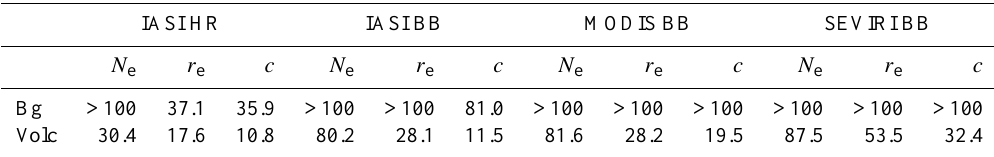
Table 4. Total error (%) for the retrieval of the three aerosol parameters: N e , r e and H 2 SO 4 mixing ratio, with different instrumental configurations (IASI HR refers to the IASI high spectral resolution; IASI BB refers to the IASI broadband features; MODIS BB refers to the MODIS broadband features; SEVIRI BB refers to the SEVIRI broadband features. See the text for further details). The error is calculated for typical background (Bg) and volcanic (Volc)